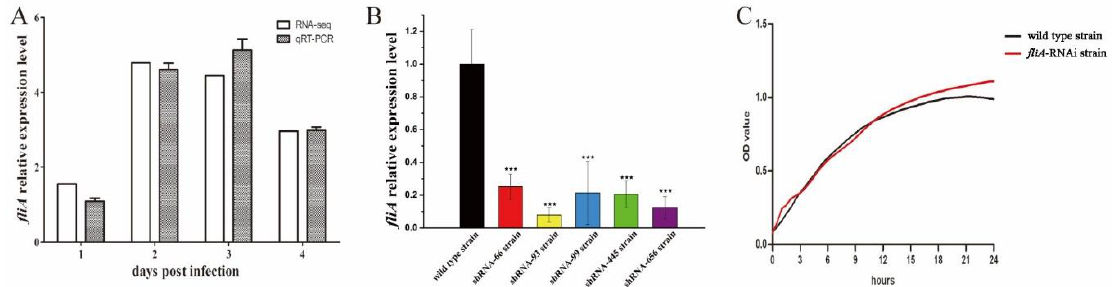
Figure 1. Construction of the fliA -RNAi strain of P. plecoglossicida . ( A ) Relative expression of fliA at 1, 2, 3 and 4 days post-infection. Each data comes from three samples. ( B ) Relative expression of fliA in five mutant strains of P. plecoglossicida . Each data comes from three independent experiments. ( C ) growth curve of P. plecoglossicida . Each data point comes from 12 technical repeats. (cid:70)(cid:70)(cid:70) p ≤